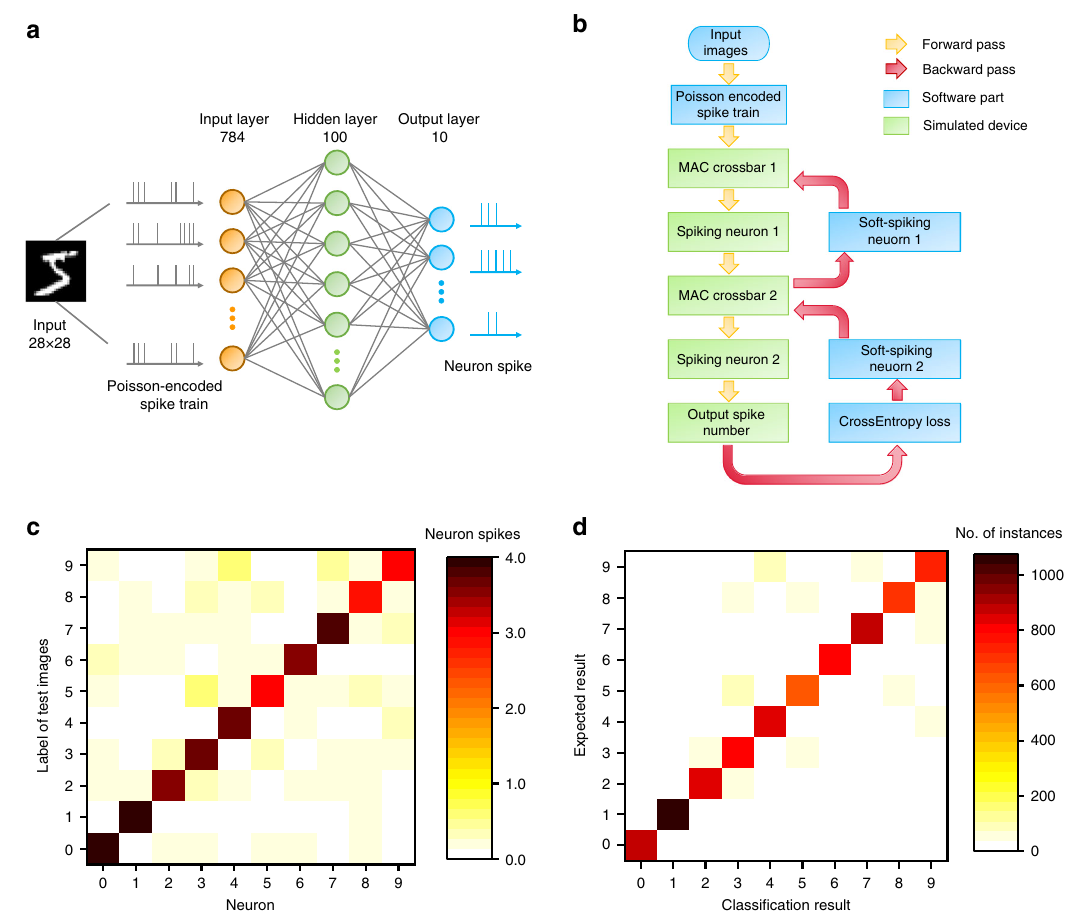
Fig. 6 A 3-layer spiking neural network by simulation. a Schematic of the spiking neural network for MNIST classi fi cation. Input images are fi rst converted to Poisson spike trains, where the spiking rates are proportional to pixel values. The spike trains are then input to the network, weighted and integrated by the neurons. At last, we count the spiking rates of output neurons to get the prediction results. b Flow chart of the simulation process. In the forward phase (yellow arrow), input spike trains are weighted by the memristor crossbar and then integrated on neurons, and the spiking rates of output neurons are used in loss computing. In the backward phase (purple arrow), a soft function like sigmoid is used as an alternative to neuron spike function (step function) in gradient computing. The computing units in green boxes are simulated based on experimental data, while the units in blue boxes are implemented by software. c In the case where the input picture is correctly identi fi ed, the statistics of the fi ring numbers issued by ten neurons in the case of input pictures corresponding to the MNIST numbers themselves. Statistics of fi ring numbers of the category neurons in response to different inputs, showing that the inputs are classi fi ed correctly in most cases. d Averaged confusion matrix of the testing results, showing that the test inputs are well classi fi ed after